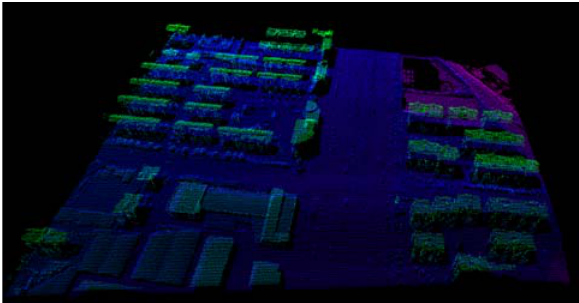
Figure 4. 3D point cloud section of urban area derived from the full-waveform data using PWD